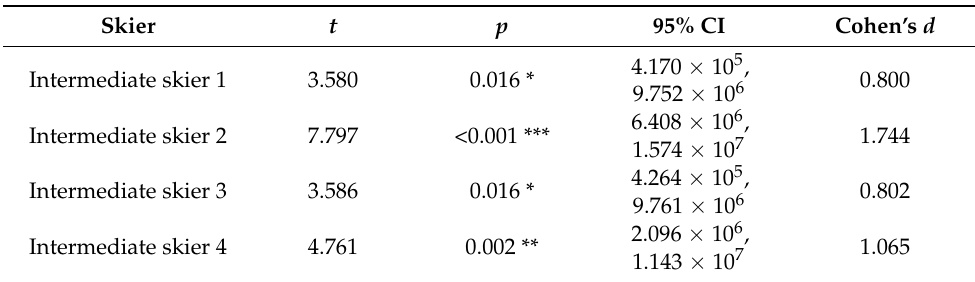
Table 1. Results of the post-hoc comparisons for the quantitative ski motion feature. The expert skier was compared to each intermediate skier.